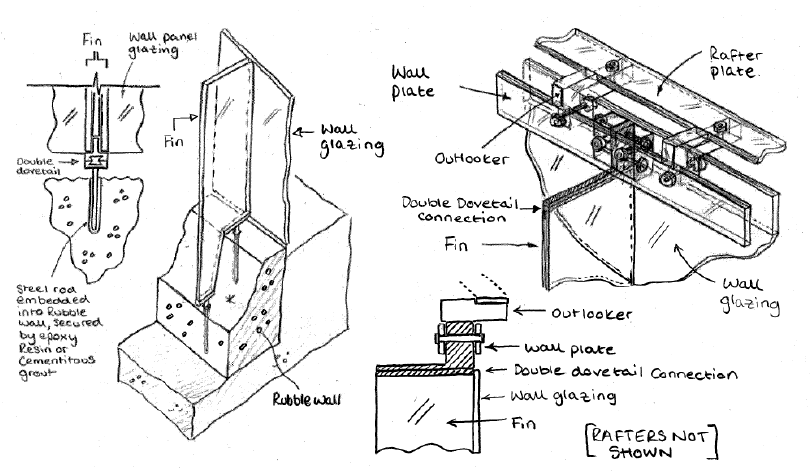
Figure 9a: Fin Connection to Masonry. Figure 9b: Fin Connection to Wall